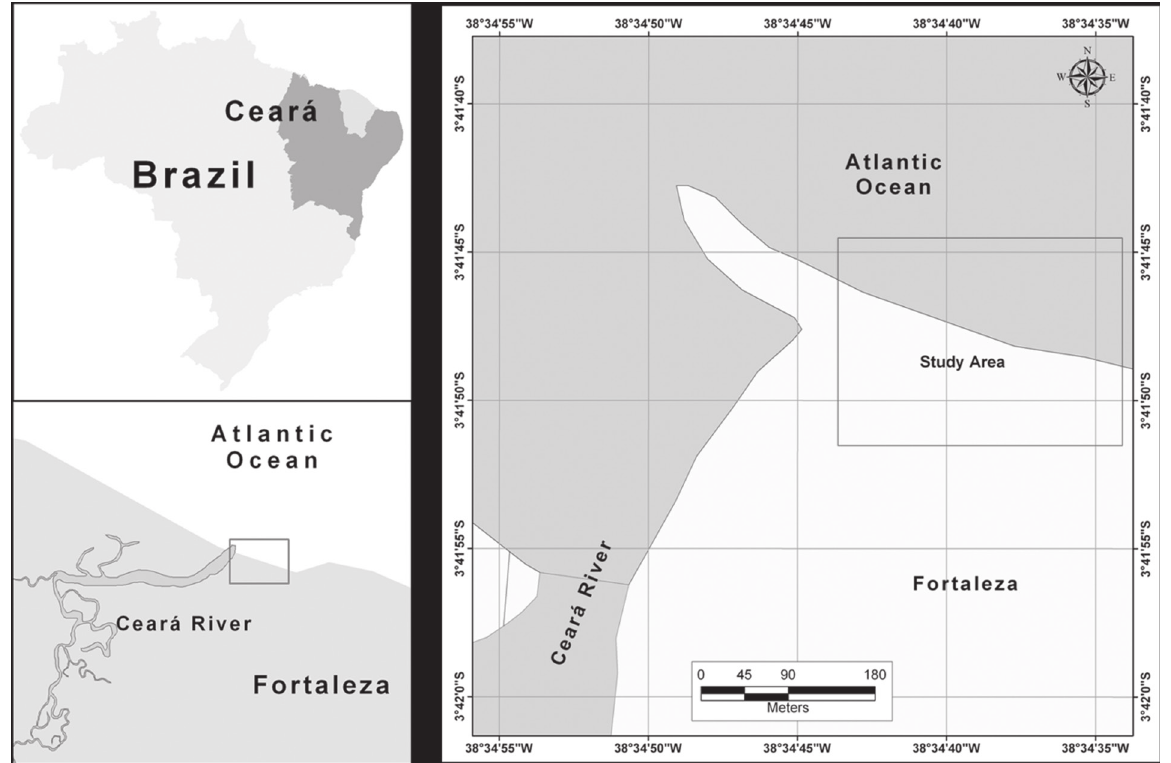
Figure 1 - Location of the study area. Goiabeiras Beach, Fortaleza-Ceará-Northeastern